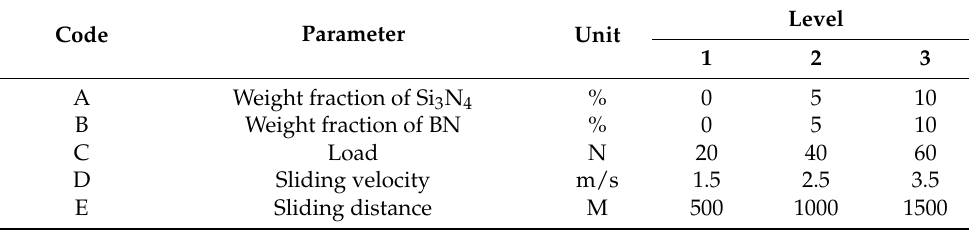
Table 3. Independent Process Parameters and their